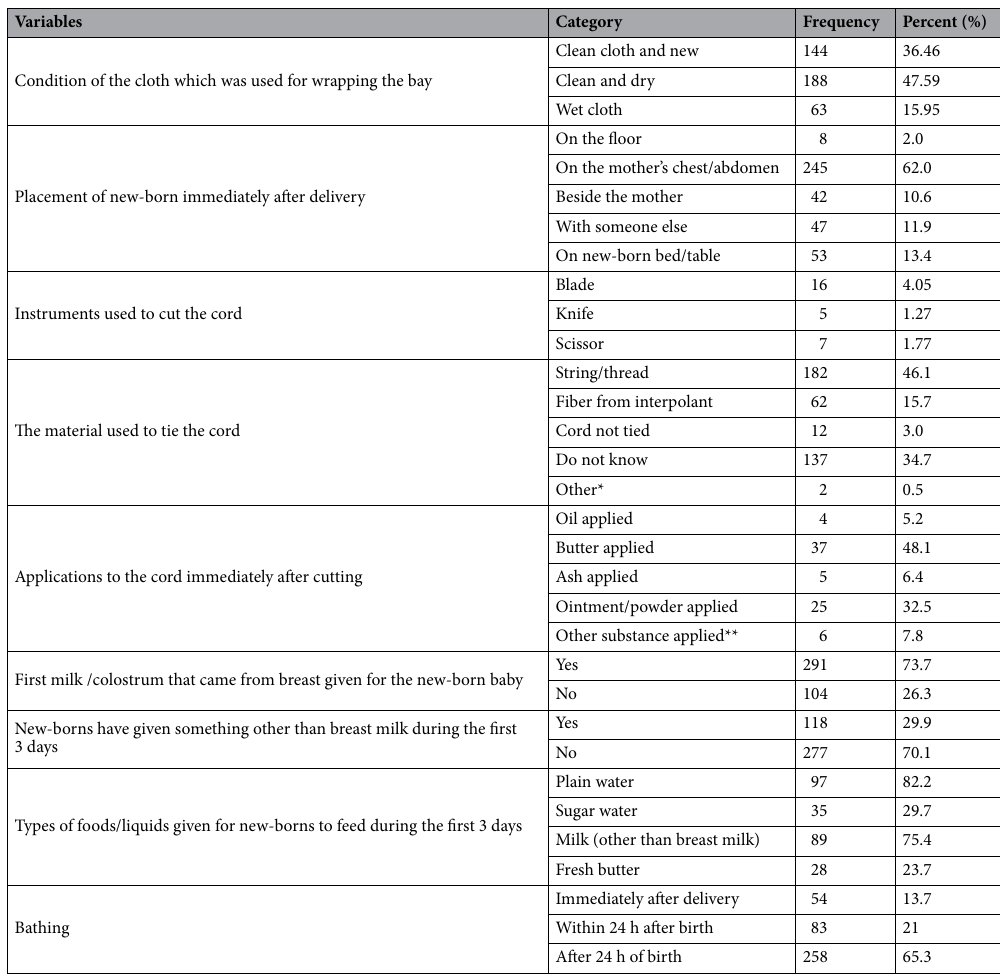
Table 3. Immediate neonatal care practices of mothers in North Shewa zone, Oromia Region, Ethiopia (N = 395). BCG Bacille Calmette-Guérin, OPV0 Oral polio vaccine at birth. *Cotton tie. **Chlorhexidine,